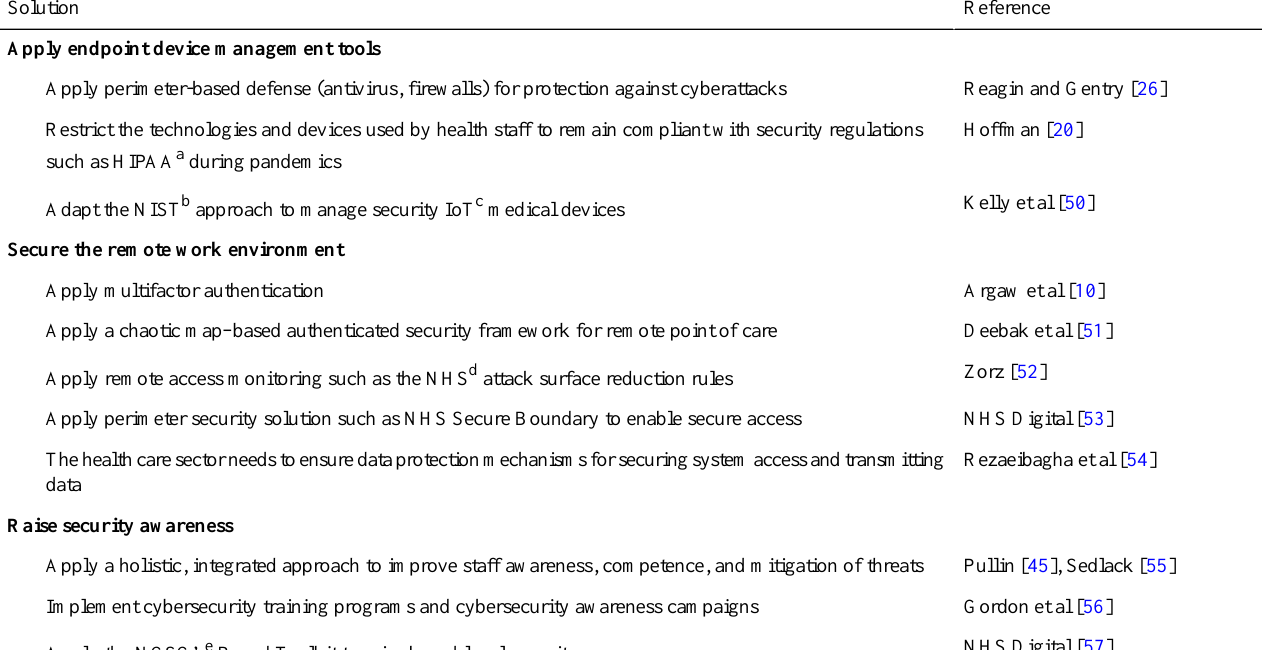
Table 4. Crucial health sector security